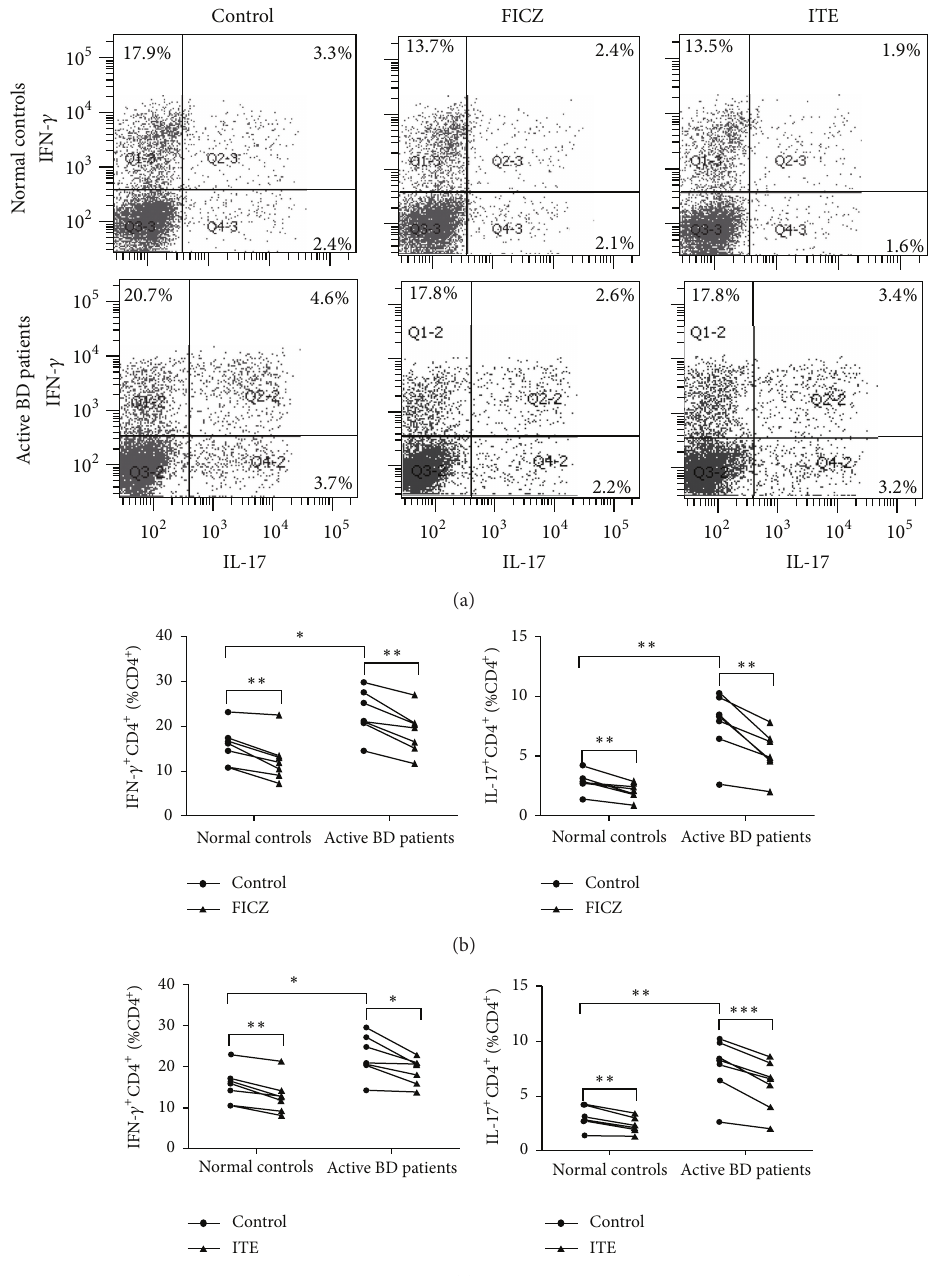
Figure 4: FICZ and ITE inhibit Th1 and Th17 cell polarization by CD4 + T cells from BD patients and normal controls. Purified CD4 + T cells from active BD patients ( 𝑛 = 7 ) and normal controls ( 𝑛 = 7 ) were stimulated with anti-CD3/CD28 and rIL-23 in the presence or absence of FICZ (100nmol/L) or ITE (100nmol/L) for 6 days. The cells were collected and analyzed for intracellular expression of IFN- 𝛾 and IL-17 by flow cytometry. (a) Dot plots of a representative subject for each group are shown. (b and c) Quantitative analysis of the percentage of IFN- 𝛾 - and IL-17-expressing CD4 + T cells. Paired-sample t test or Wilcoxon’s matched-pairs test for related samples and Independent-Sample t test for independent samples were used for statistical analyses. ∗ 𝑃 < 0.05 , ∗∗ 𝑃 < 0.01 , and ∗∗∗ 𝑃 < 0.001